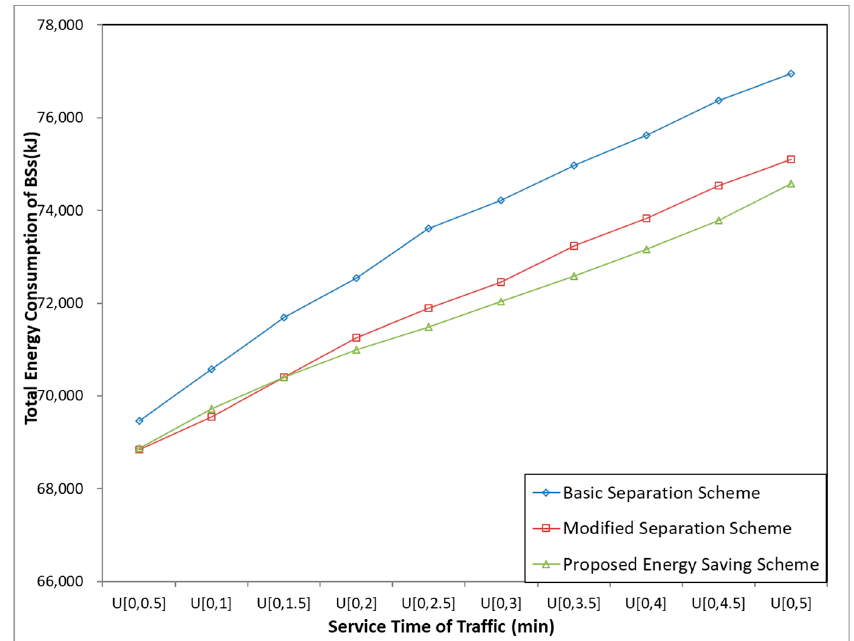
Figure 19. Total energy consumption of BSs.